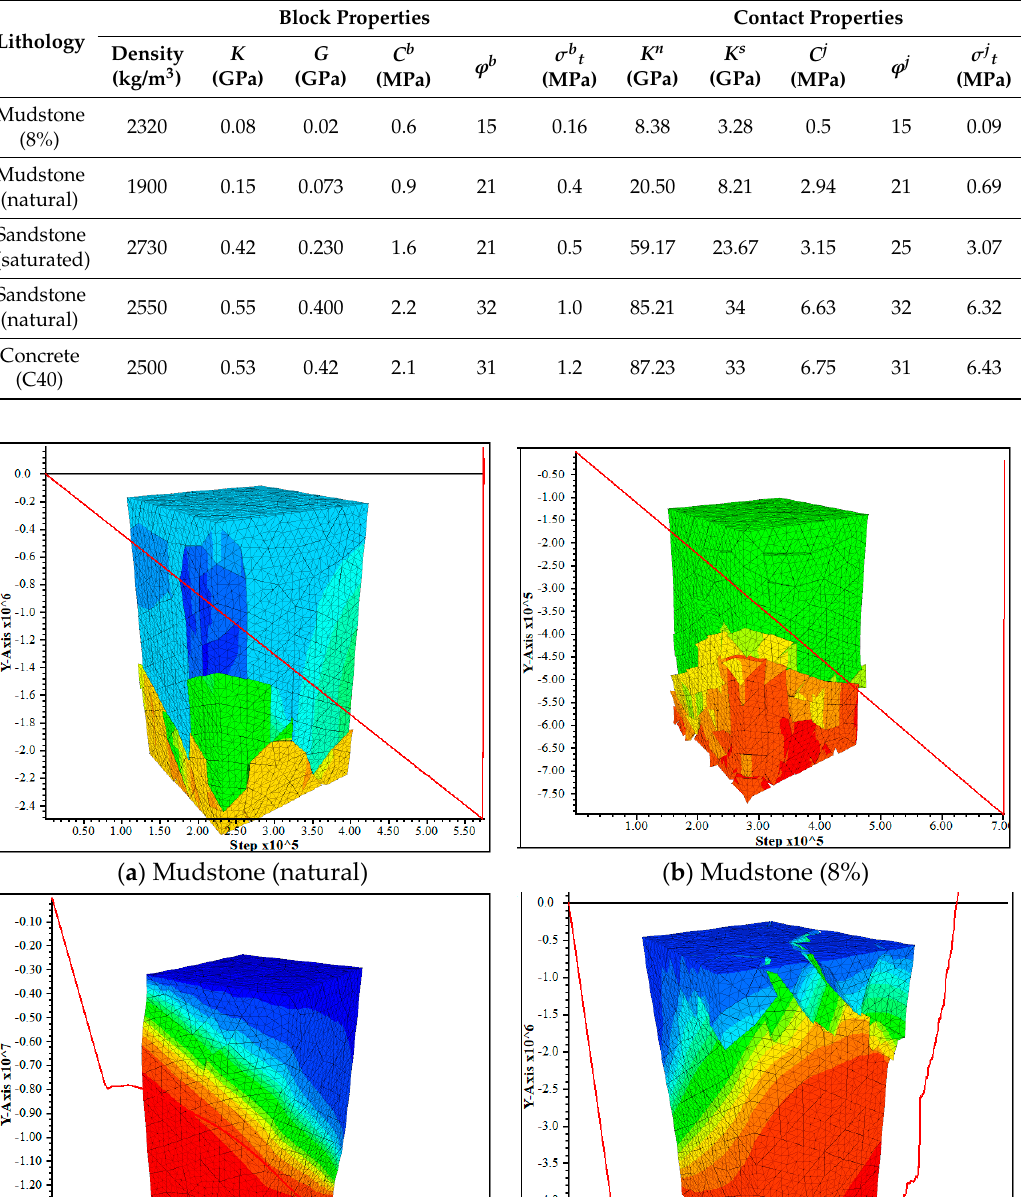
Table 4. Parameters for the rock mass.